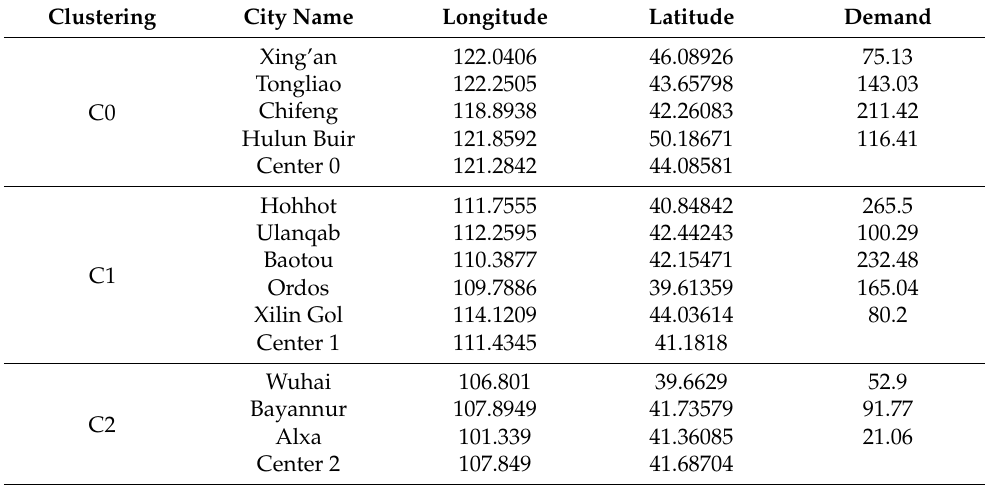
Table 5. The location results for the 2SM.